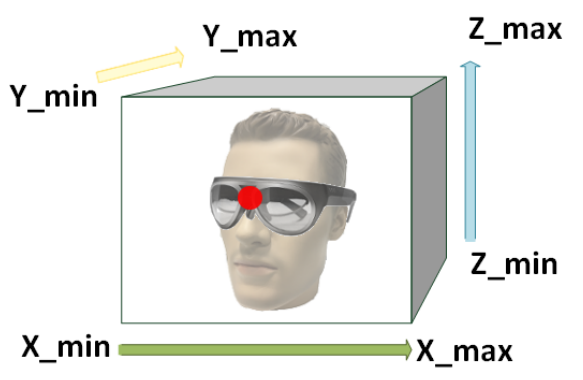
Figure 5. Prediction relative to object box. The predicted translation (red) is relative to a predefined object box. The borders of this box have been determined as the minimum and maximum translation values per axis based on the ground truth